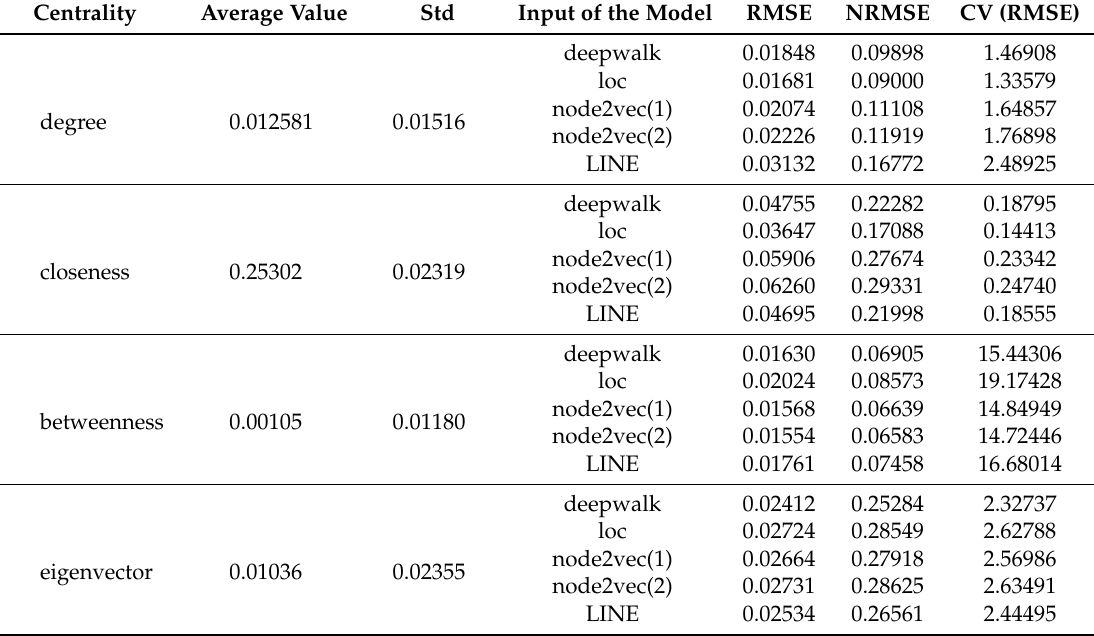
Table 4. Root Mean Squared Error (RMSE), Normalized Root Mean Squared Error (NRMSE) and Coefficient of Variation of the RMSE for approximating centrality values in the Facebook